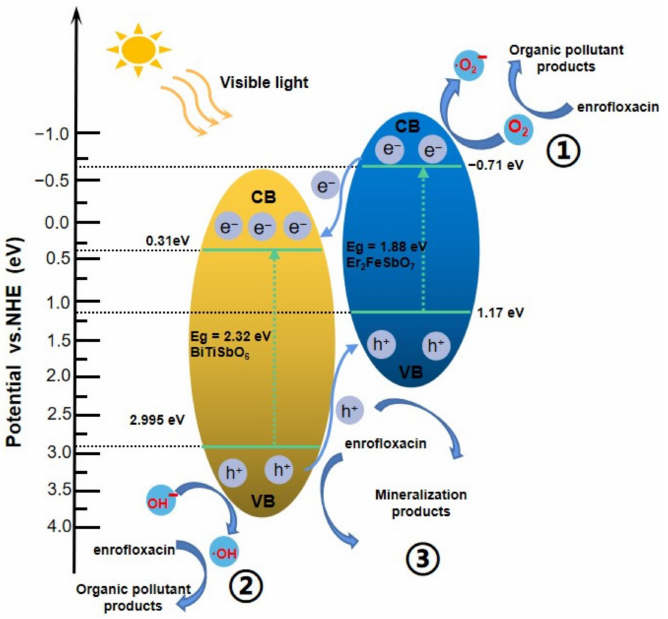
Figure 19. Possible PCD mechanism of ENR with EBH as photocatalyzer under